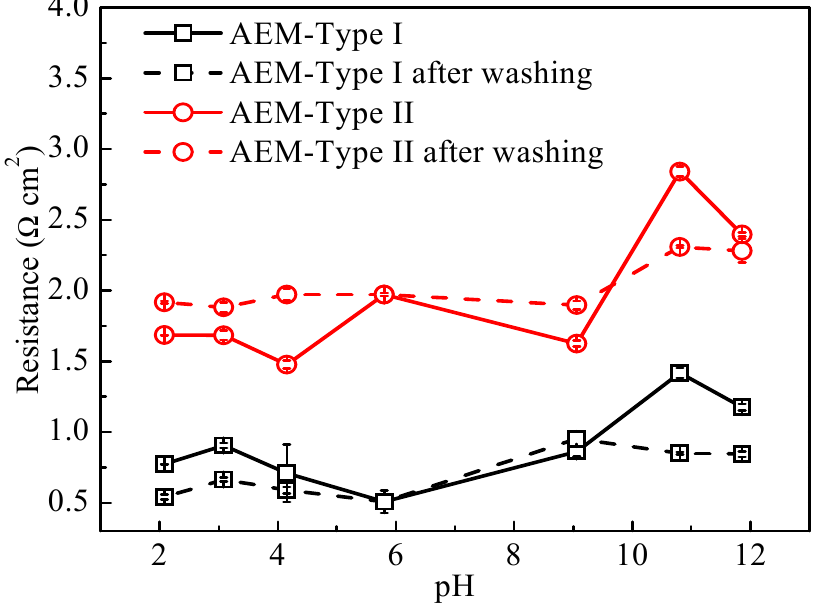
Figure 9. Membrane resistance of anion exchange membranes before and after washing with 0.5 mol/L NaCl solution.